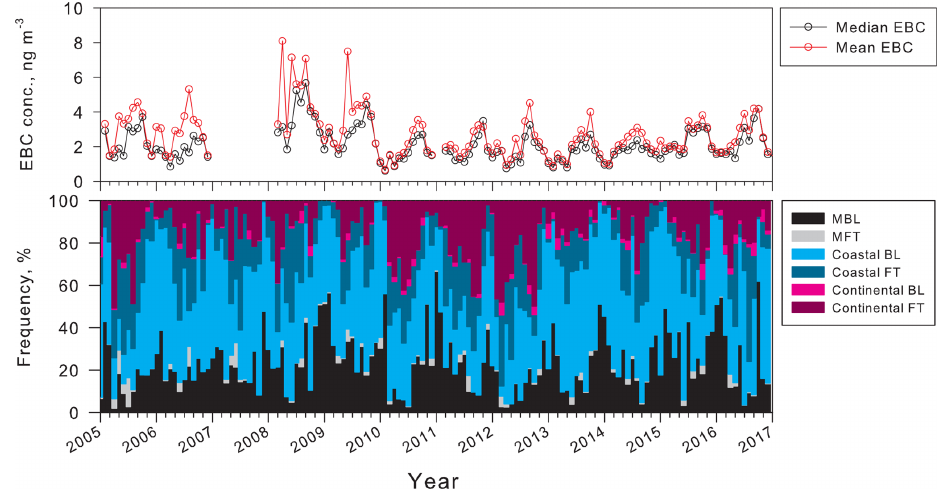
Figure 6. Seasonal features of monthly mean and median EBC concentrations, and air mass origins at Syowa Station. MBL, MFT, coastal BL, coastal FT, continental BL, and continental FT respectively denote the marine boundary layer, marine free troposphere, coastal boundary layer, coastal free troposphere, continental boundary layer, and continental free